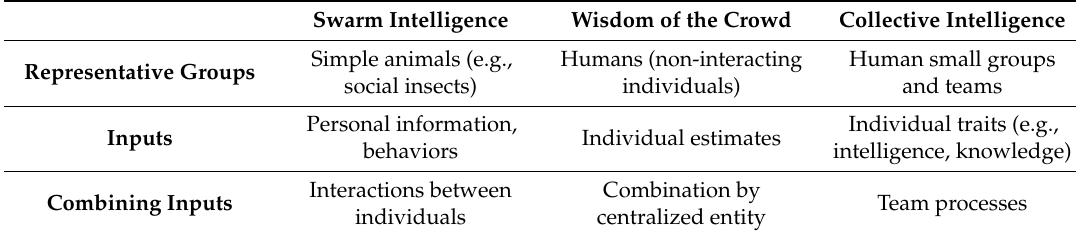
Table 1. Di ff erentiating Forms of Group-Level